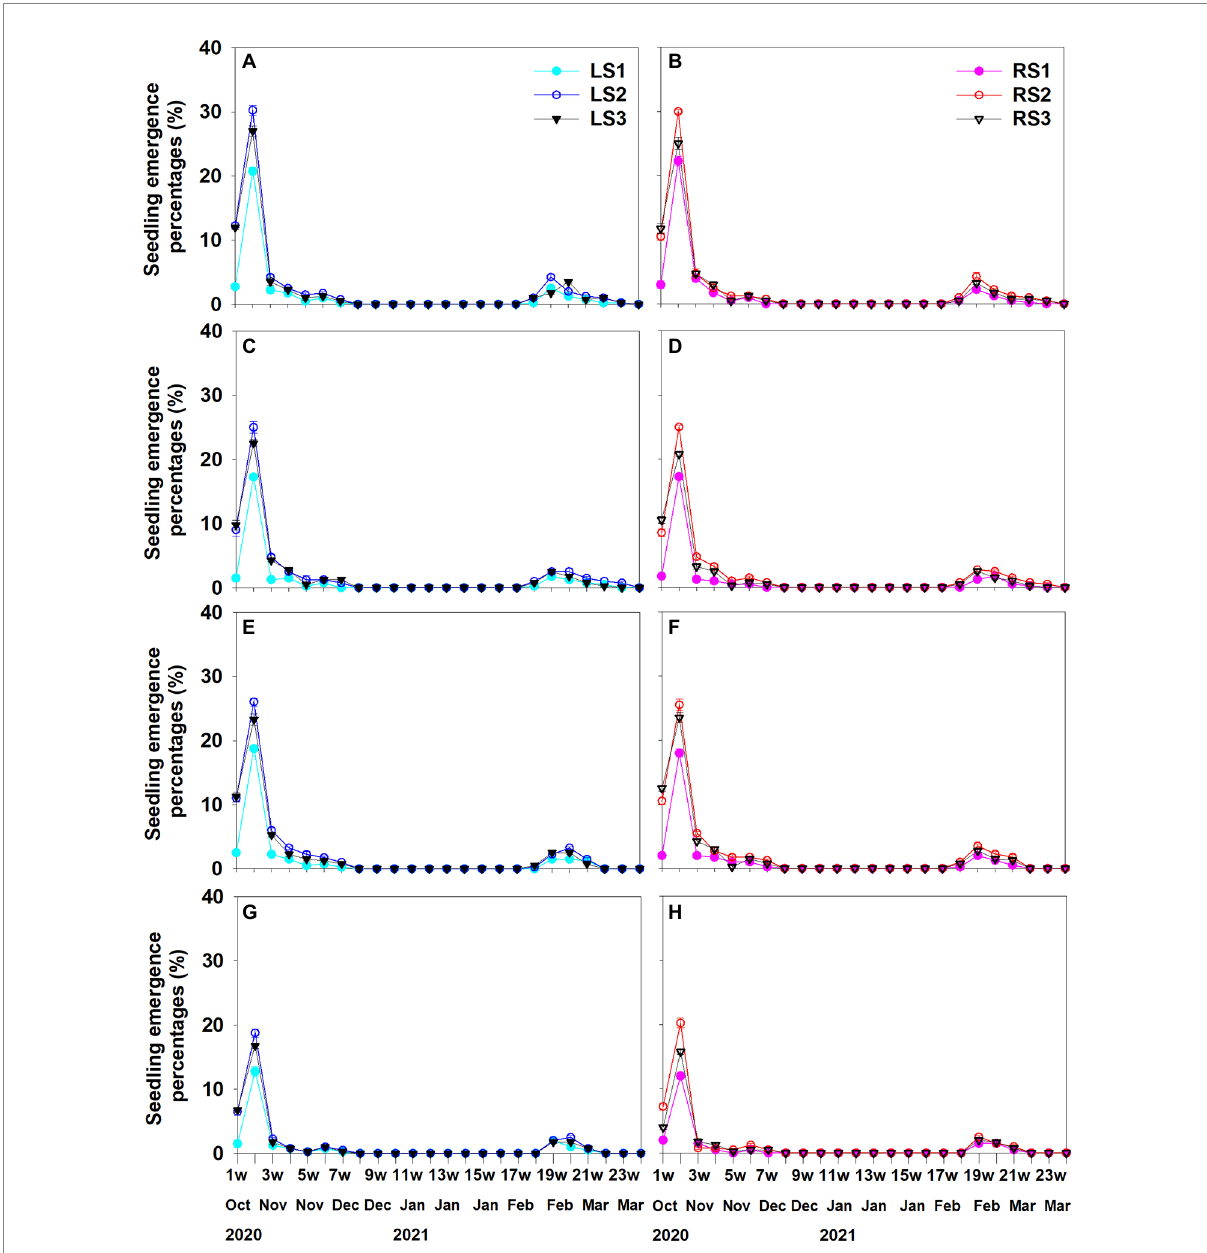
FIGURE 6 Seedling emergence from seeds separated from Left (A, C, E, G) and Right (B, D, F, H) spikelet types of Aegilops tauschii sown in field plots on October 18, 2020. (A, B) seedling emergence under added fertilizer and watered regularly condition; (C, D) seedling emergence under added fertilizer and natural moisture condition; (E, F) seedling emergence under no fertilizer and watered regularly condition; (G, H) seedling emergence under no fertilizer and natural moisture conditions; LS, seedlings derived from seeds in spikelet type Left; RS, seedlings derived from seeds in spikelet type Right. Numbers 1, 2 or 3 following LS and RS indicate different seed